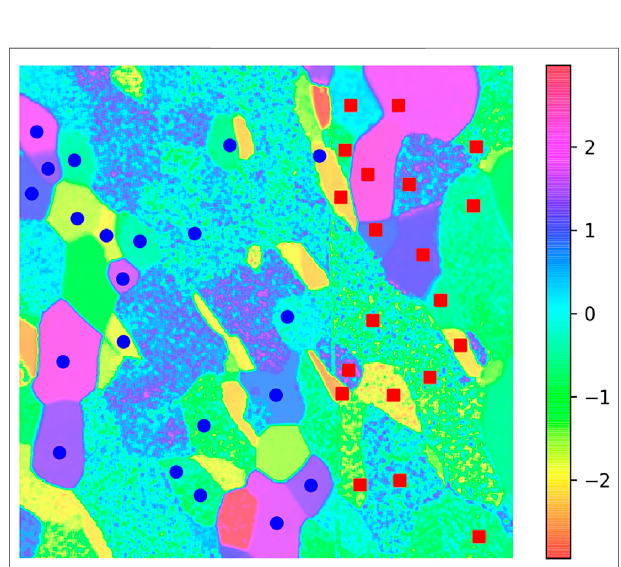
FIGURE 4 | Locations of the manually selected block. The blocks from the two regions with different (query) are marked with different markers: one with blue dots and the other with red